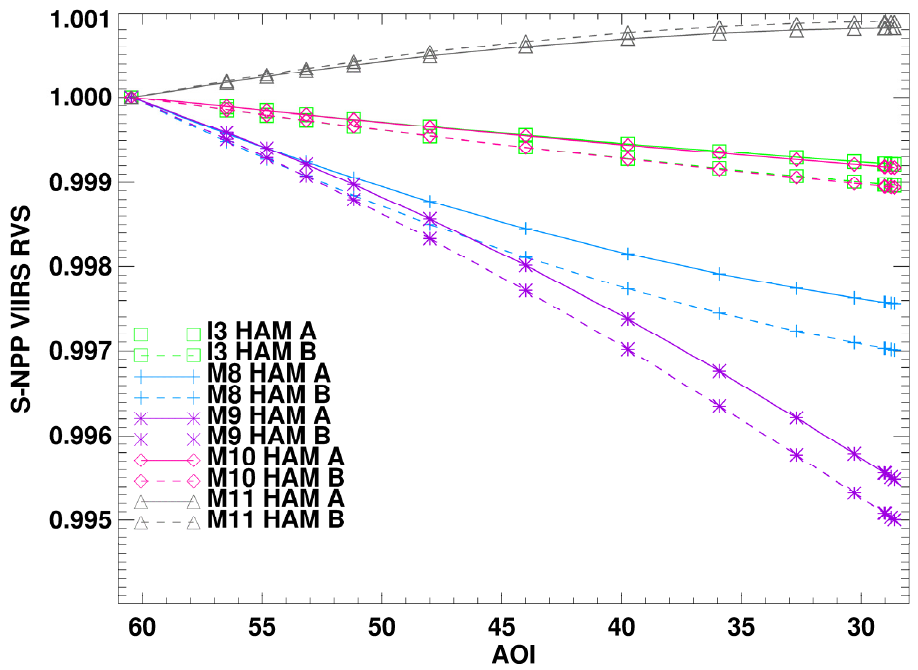
Figure 13. Band-averaged RVS for S-NPP VIIRS RSBs from the SV AOI to the end of scan AOI for bands I3 and M8–M11.